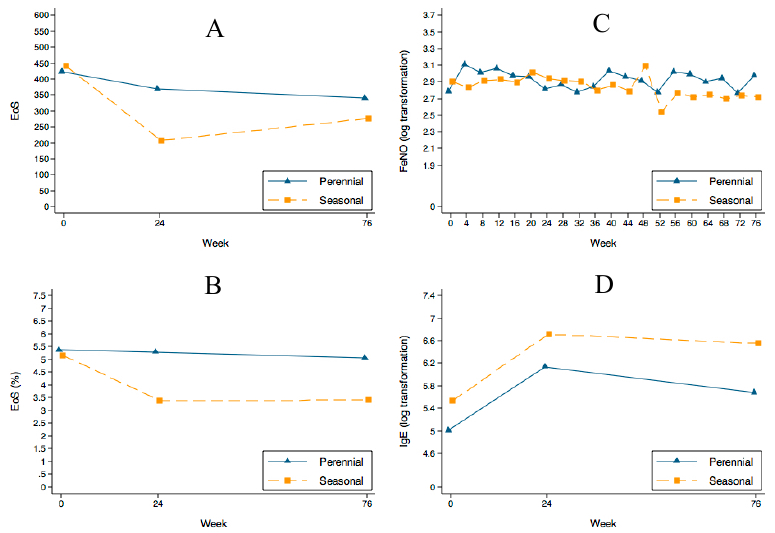
Figure 3. Changes in eosinophil count, FeNO and IgE values during follow-up in both groups. ( A , B ) show the decrease in eosinophils. A non-statistically significant trend towards a decrease in the absolute number of cells ( p = 0.086) was found. Although the difference was not statistically significant, the seasonal group showed a more marked decrease. FeNO values ( C ) remained stable along the follow-up and the IgE concentration ( D ) initially increased in both groups—as expected—and showed a trend to stabilize or slightly decrease during follow-up.